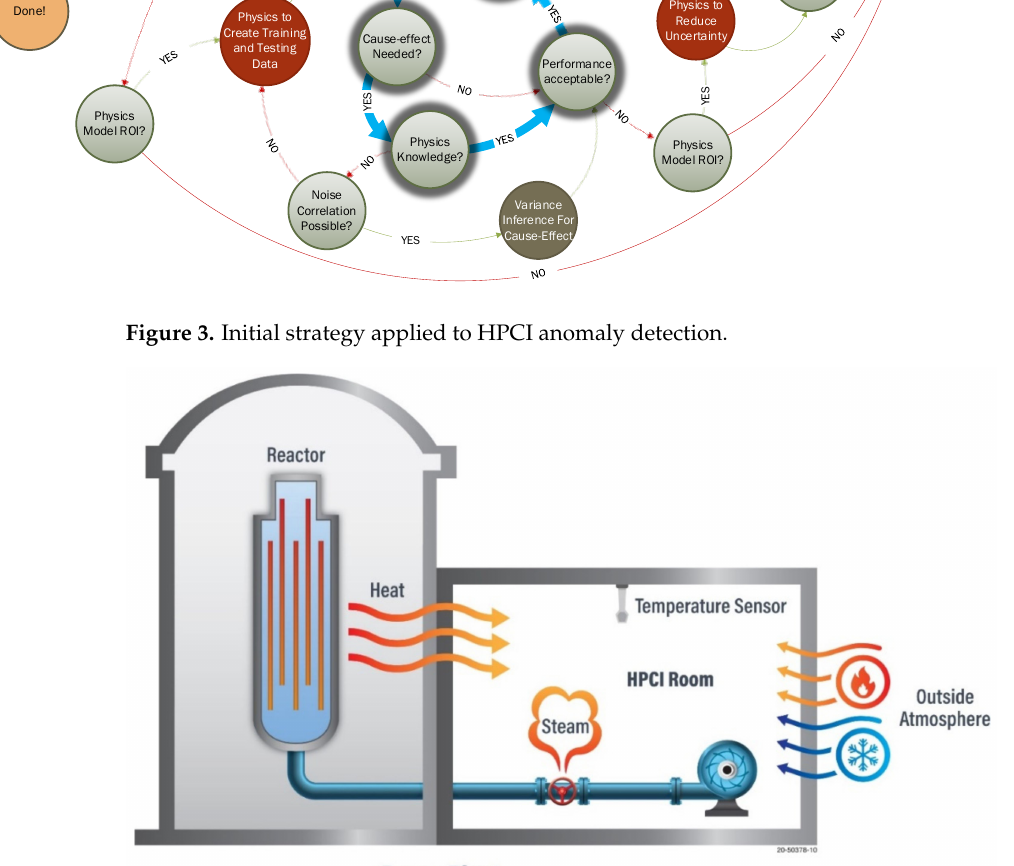
Figure 4. Simplified schematic of the HPCI room setup. The data were reduced to three influences on room temperature: contributions as a result of reactor power, contributions from the outside atmosphere, and potential